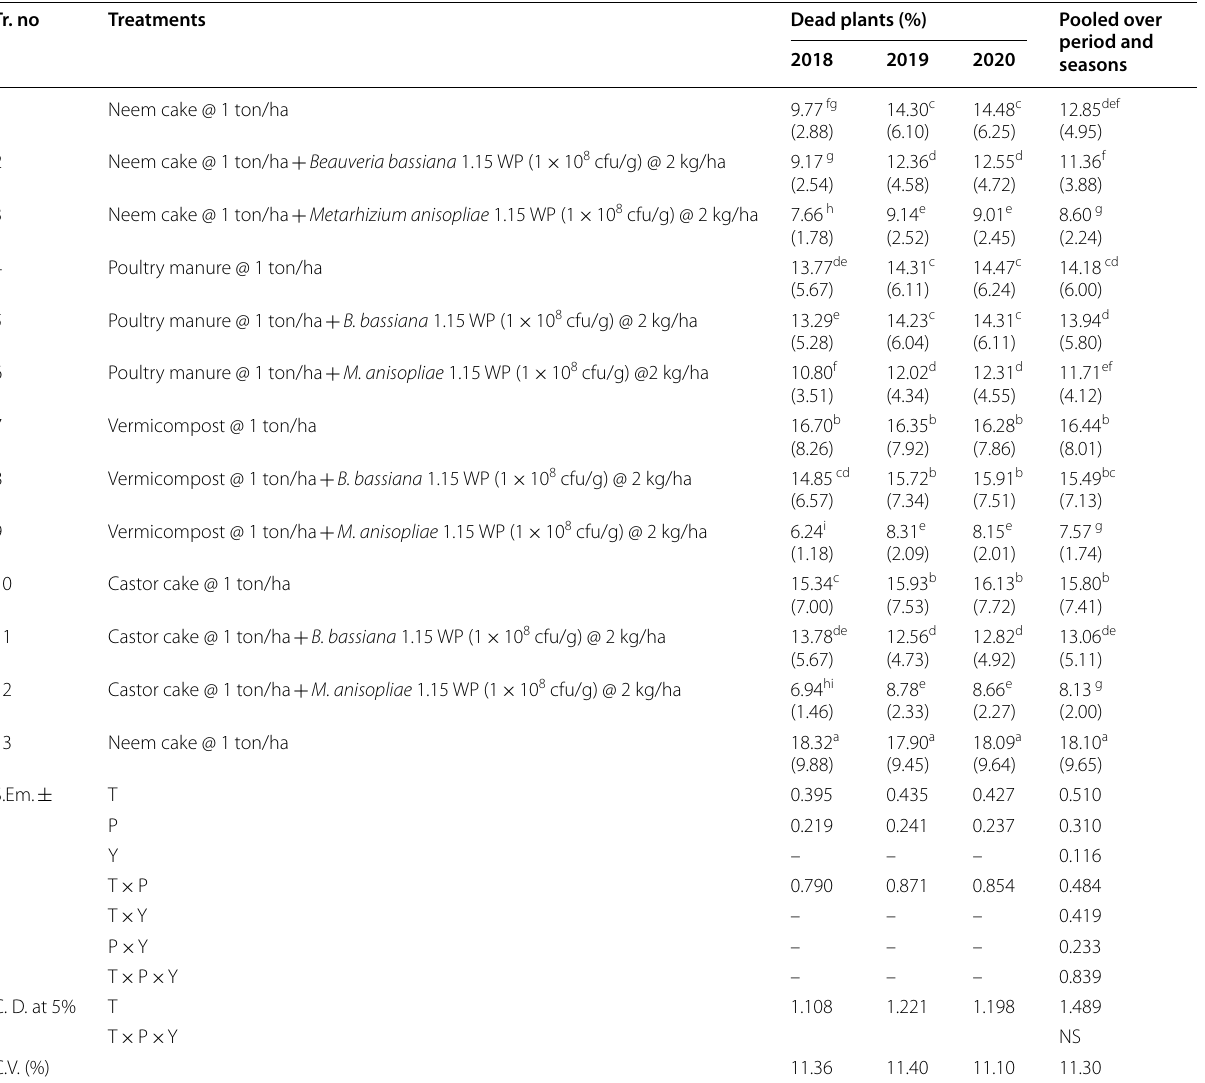
Table 5 Effect of entomopathogenic fungi enriched with organic amendments against white grub in groundnut (pooled over period and